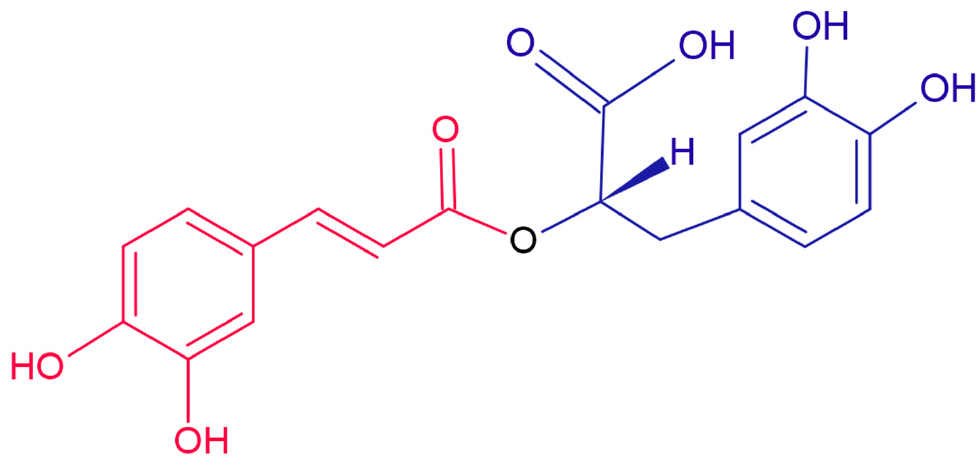
Figure 1. Chemical structure of rosmarinic acid .